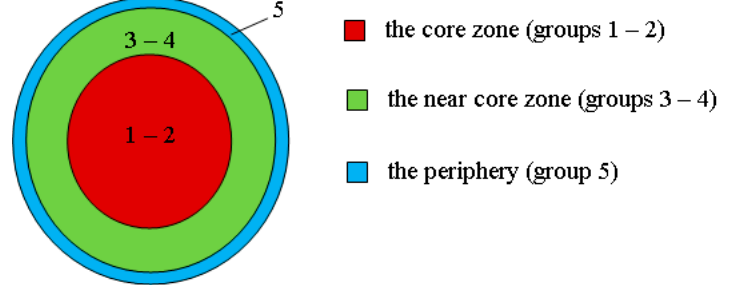
Figure 3. The associative verbal field “the Arctic” in the collective consciousness of student youth.